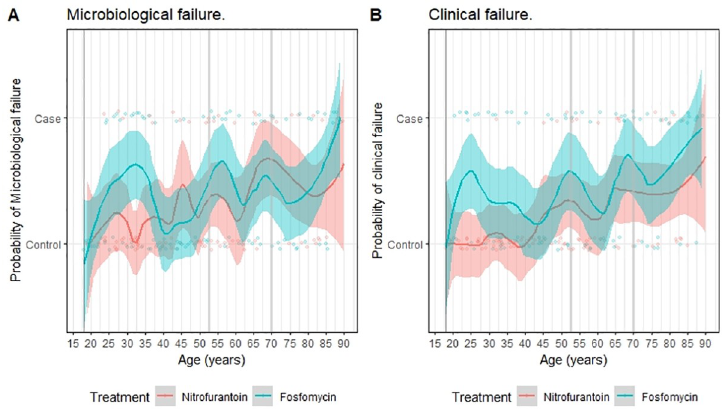
Fig 2. Variation of clinical and microbiological failure across different age groups and treatment